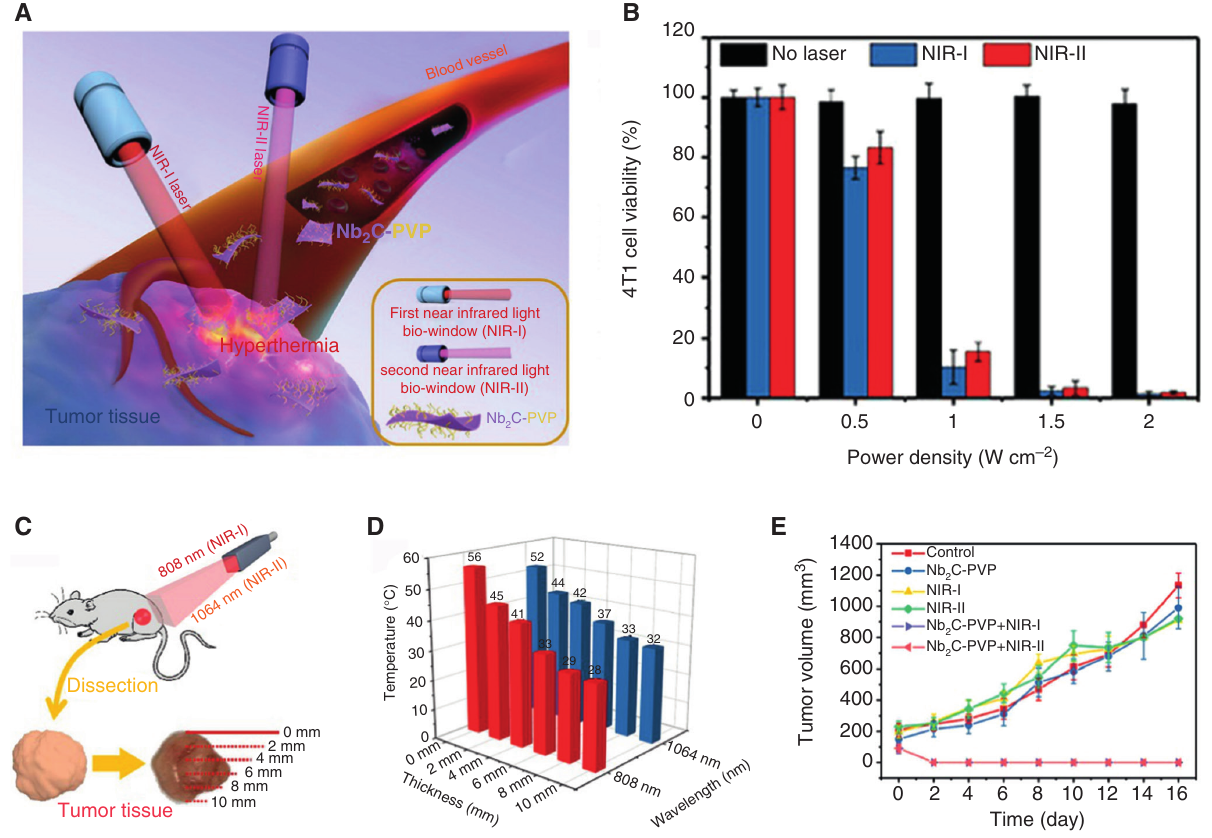
C-PVP Mxene at NIR-II. Figure 6: Photothermal therapy for tumor ablation by Nb 2 (A) Schematic illustration of photothermal tumor ablation in both NIR-I and NIR-II biowindows with Nb C-PVP MXene nanosheets. 2 (B) Cytotoxicity evaluation of Nb C-PVP MXene nanosheets without and with laser irradiation. (C) NIR-I and NIR-II laser tumor tissue 2 penetration experimental diagram. (D) Photothermal conversion performance of Nb C MXene nanosheets in tumor tissues upon NIR-I and 2 NIR-II laser irradiation. (E) Tumor growth curve after various